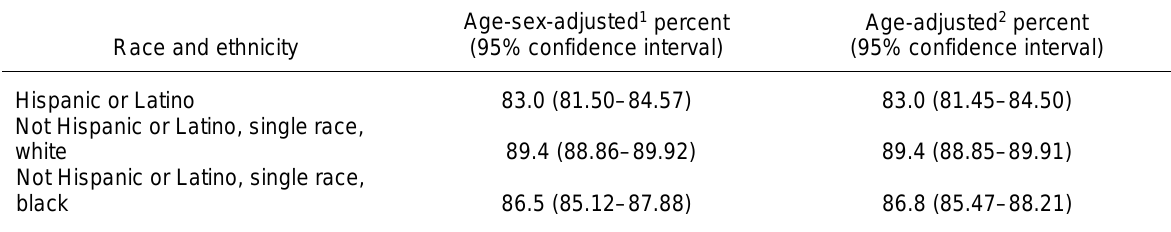
Data table for Figure 2.3. Age-sex-adjusted percentage of persons of all ages